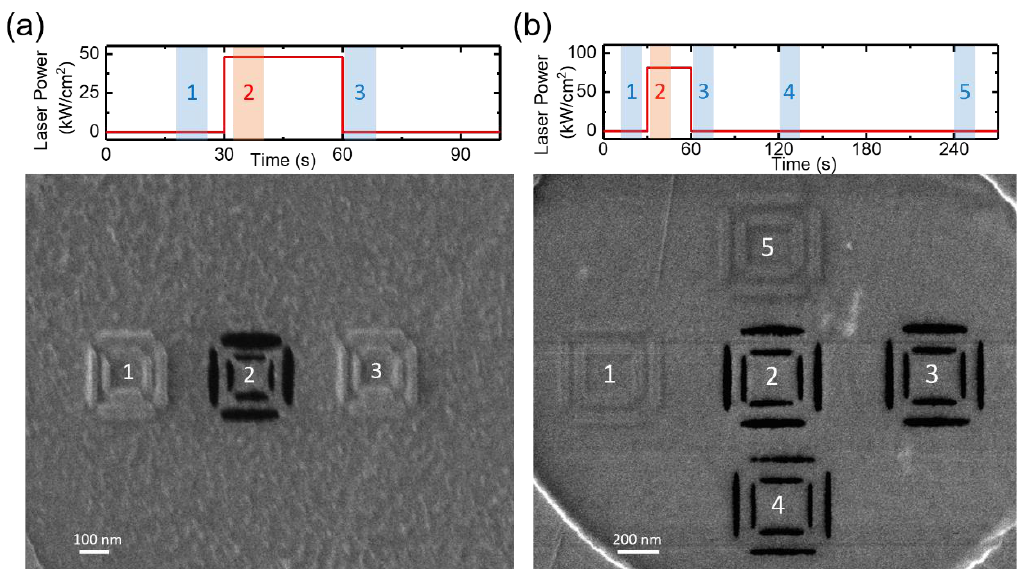
Figure 4. Effect of post-exposure time pulse laser-assisted graphene milling with low ( a ) and high ( b ) laser irradiance. Graphene milling versus carbon deposition switches immediately at 48 kW/cm 2 laser irradiance. By increasing the irradiance to 81 kW/cm 2 , the residual carbon is mitigated for over 1 min after the laser is turned off. In this test the writing time for each pattern is 8 to 15 seconds. The in situ laser parameters were set at 10 μs p ulse width and 100 Hz frequency and the He + dosage was at 2 × 10 5 ions/nm for all patterns.